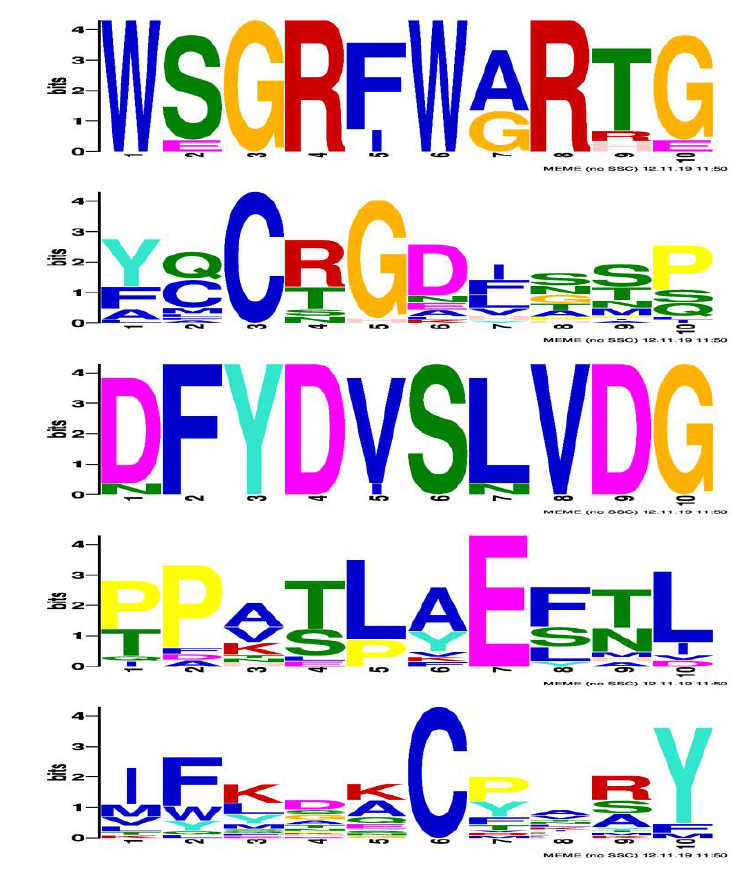
Figure 5 : The domains/motifs found by the MeMe tool in chickpea predicated anti-fungal